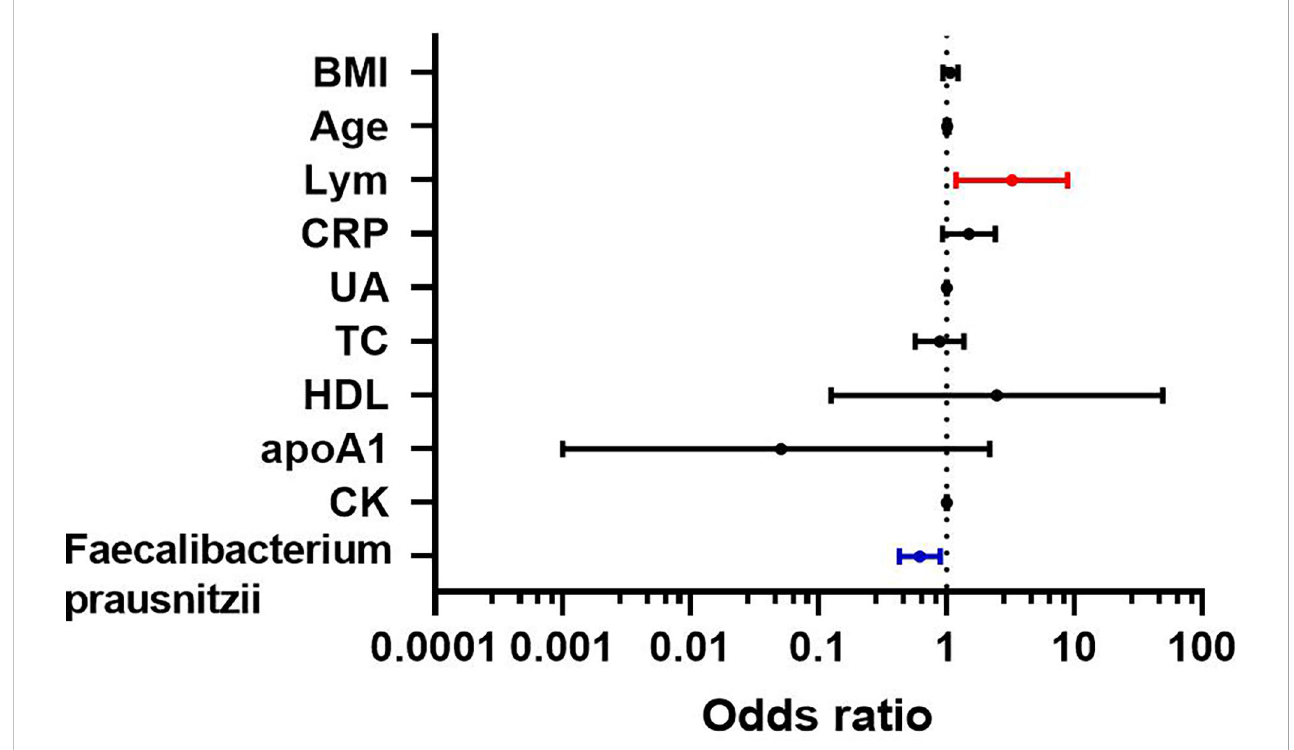
FIGURE 6 Multi-factor logistic regression analysis of obesity with